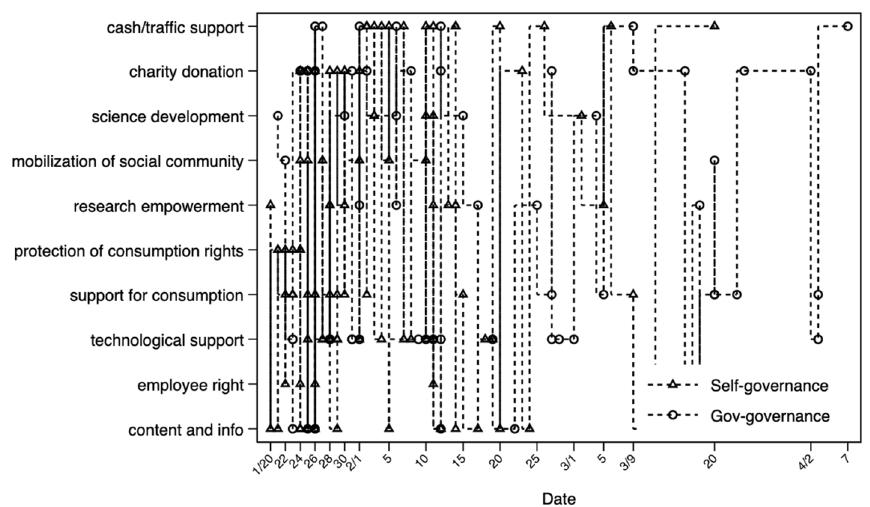
Fig. 2 Types of initiatives of top 20 Chinese digital platform companies over